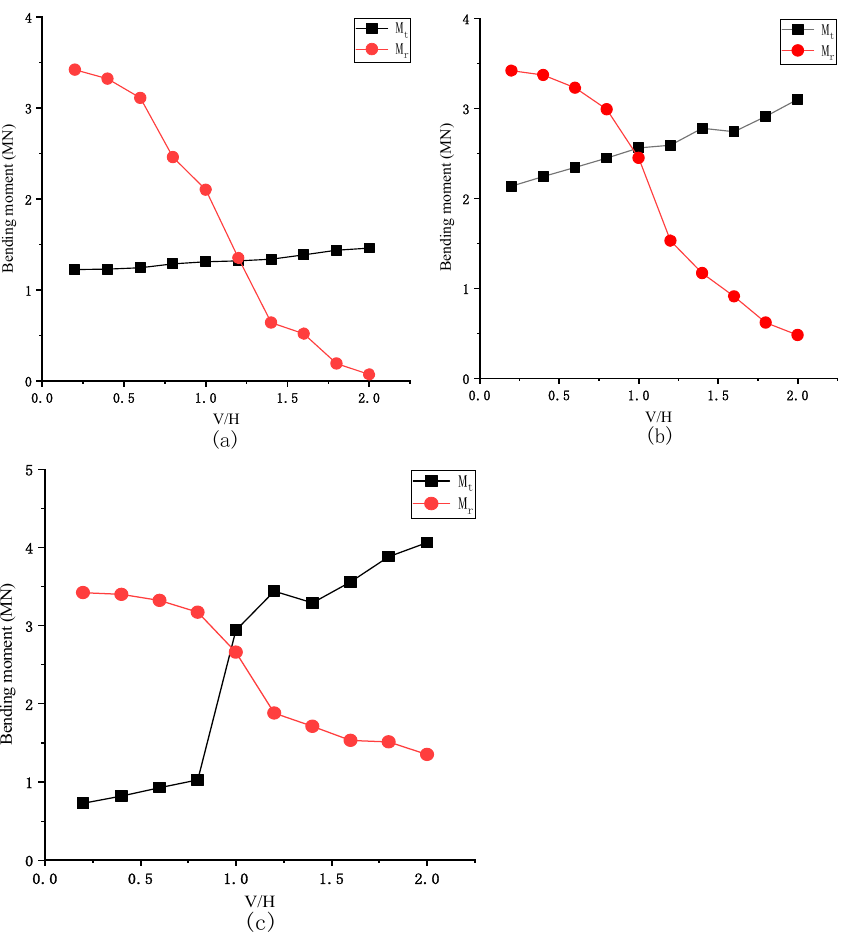
Figure 13. Bending moments at the bottom of the pier under different periods: ( a ) When H = 9 m total moment and the permissible moment pier; ( b ) When H = 12 m total moment and the permissible moment pier; ( c ) When H = 15 m total moment and the permissible moment pier.